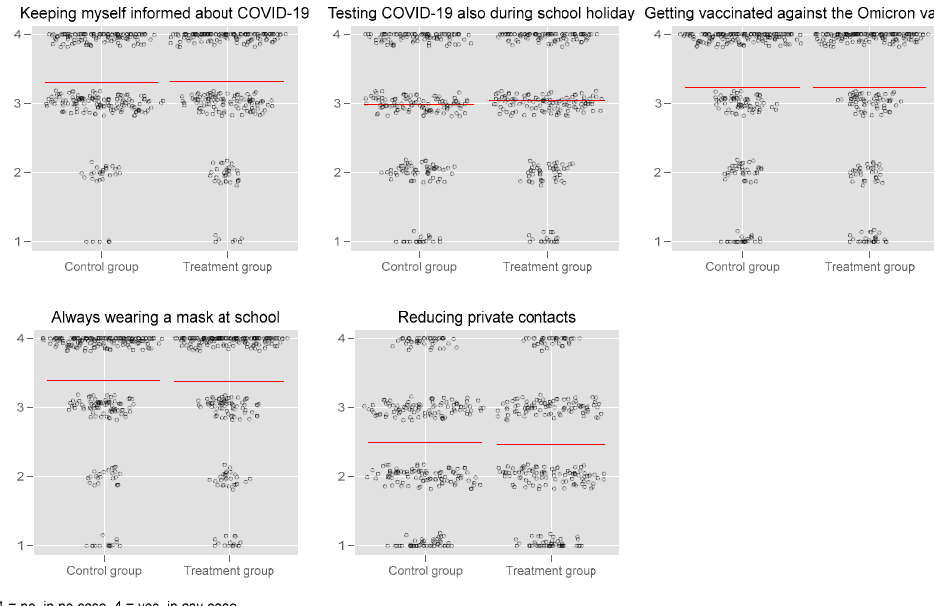
Figure 4. Willingness to perform specific anti-COVID-19 measures in treatment and control groups (+group (+group means).